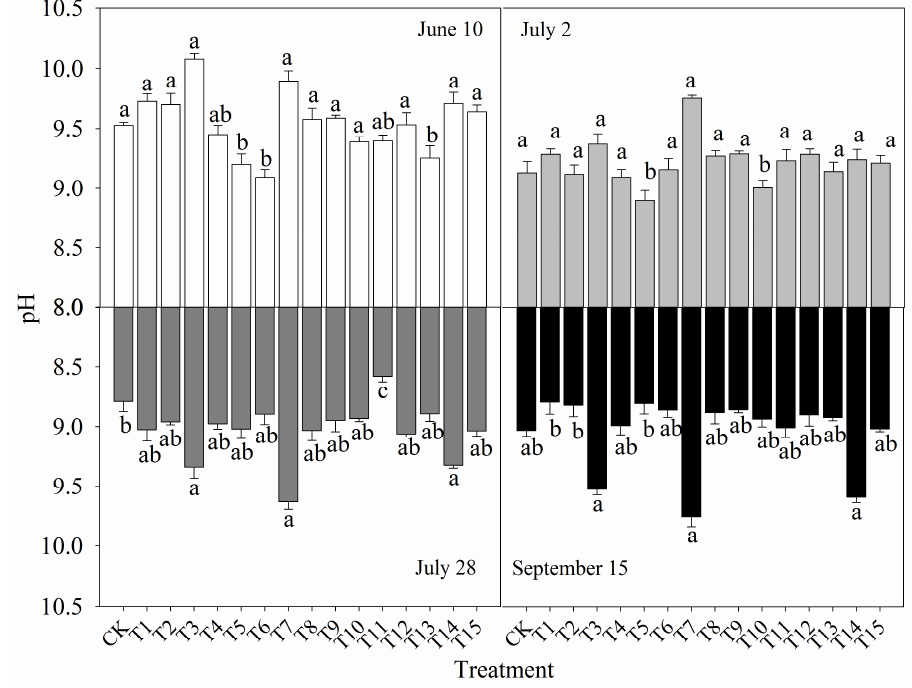
Figure 4. The average value of pH during different maize growth periods of every third treatment plot. The pH was measured at a solid/water ratio of 1:5 by pH meter (pH 211 microprocessor pH meter, HANNA, Italy). Different letters indicate significant differences between treatments at the p < 0.05 level.